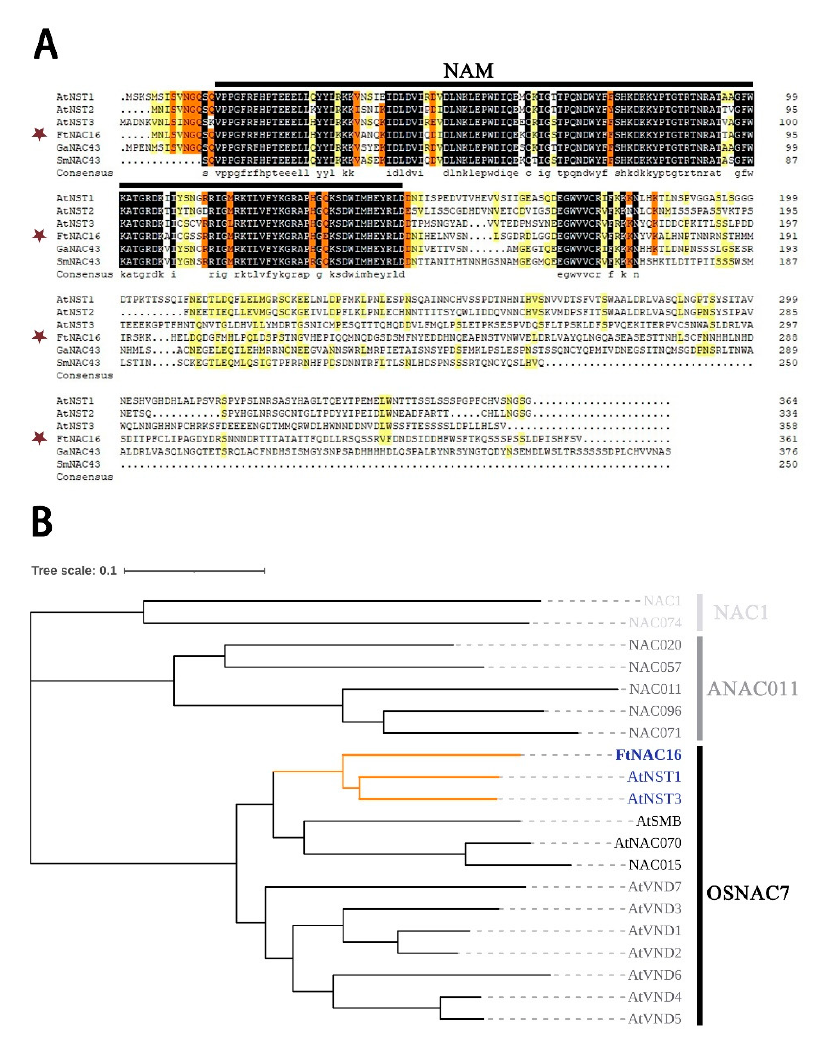
Figure 1. Sequence characteristics and homology analysis of FtNAC16. ( A ) Sequence alignment of the FtNAC16 protein and its conserved domain, represented by the black line. The GenBank accession numbers of the NAC protein areas were as follows: AtNST1 (ANAC043) (AT2G46770), AtNST2 (AT3G61910), AtNST3 (AT1G32770), FtNAC16 (FtPinG0000381200.01), GaNAC43 (XP_017629605.1) and SmNAC43 (QBZ39066.1). ( B ) Evolutionary tree analysis divides 20 NAC family genes into three subfamilies: NAC1, ANAC011 and OSNAC7. FtNAC16 and AtNST1/3 are clustered into the same branch and are shown in orange.